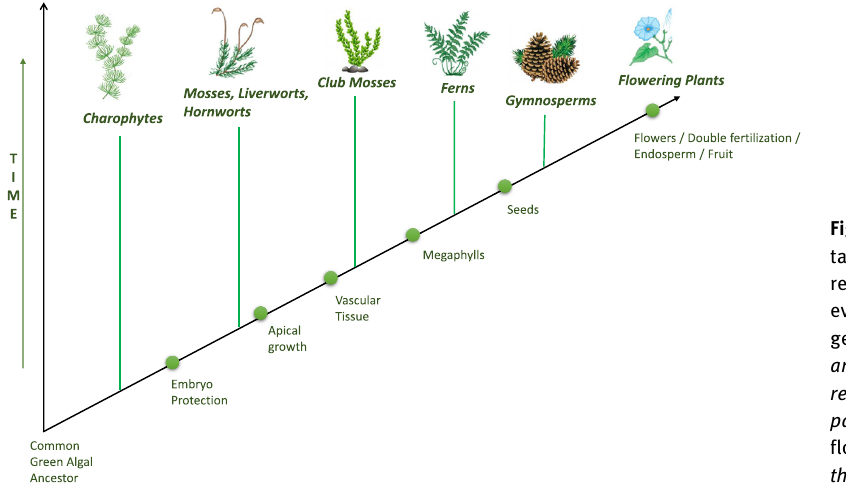
Figure2: Aschematicrepresen- tationofaphylogenetictreerep- resenting the process of plant evolution over time. The order of genomesstudiedisfrom mosses and algae (Chlamydomonas reinhardtii , and Physcomitrella patens) to more complex flowering plants ( Arabidopsis thaliana)